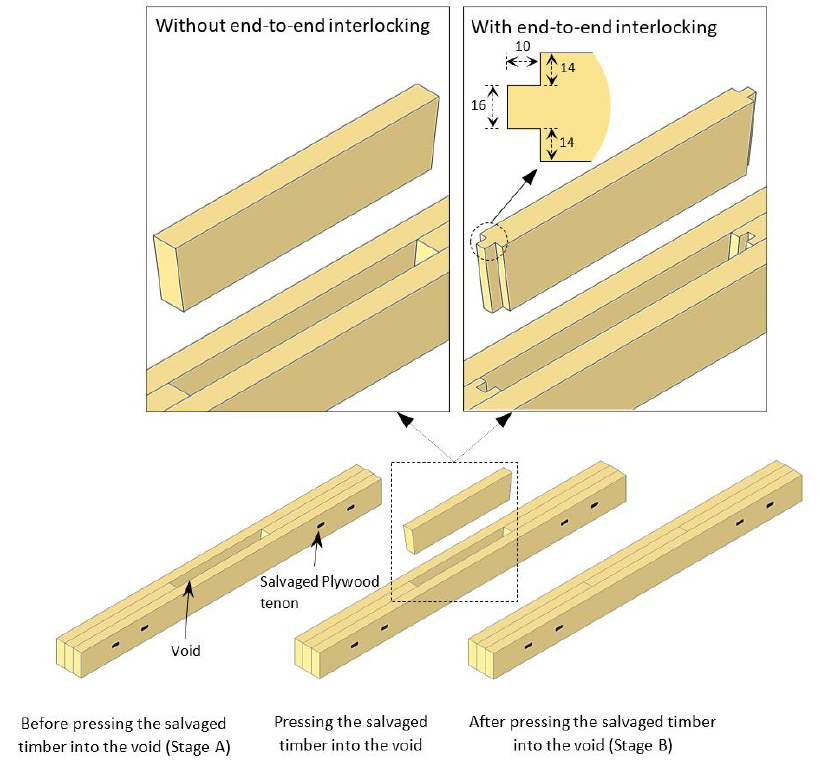
Figure 2. The configurations of the small-scale DLT panels before and after pressing the salvaged timber in the system. Dimensions in mm.